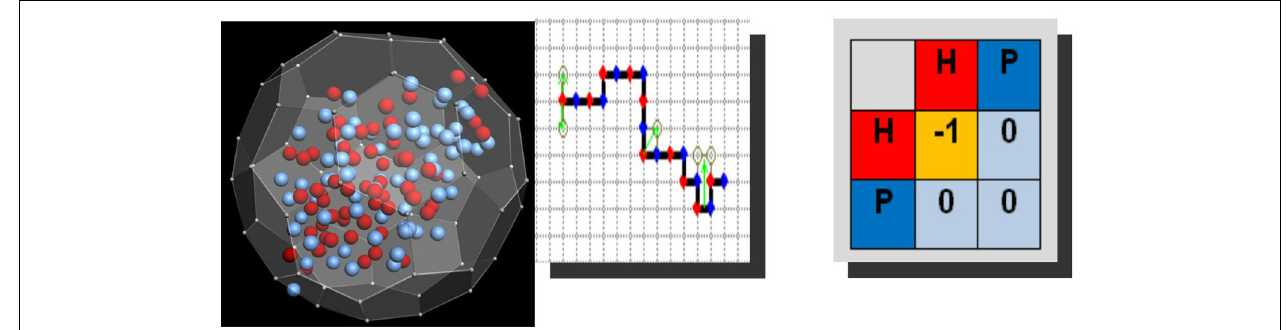
FIGURE 1 | Left: Fullerene type mesoscopic, computation-prone unit (courtesy of J. Siodmiak), equipped with a number of hydrophobic (red) and polar (blue) residues. N-G phase change, resting on these units occurs most efficiently when red residues, by their binary interactions, yield the hydrophobic attraction-prone effects. Middle and right: Spaghetti type mesoscopic unit immersed in square lattice, along which polar and